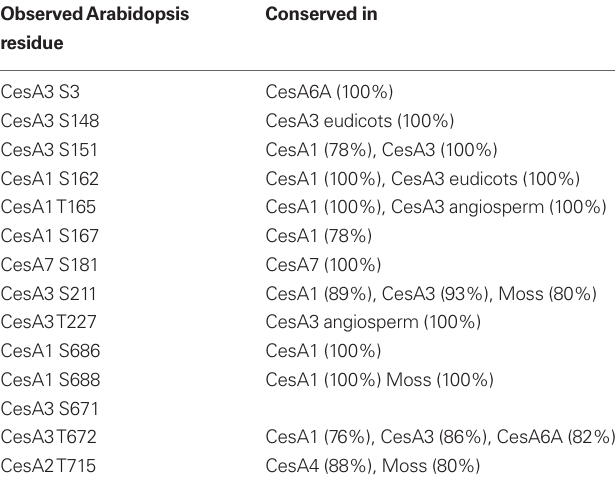
Table 3 | Conserved phosphorylation sites. Observed